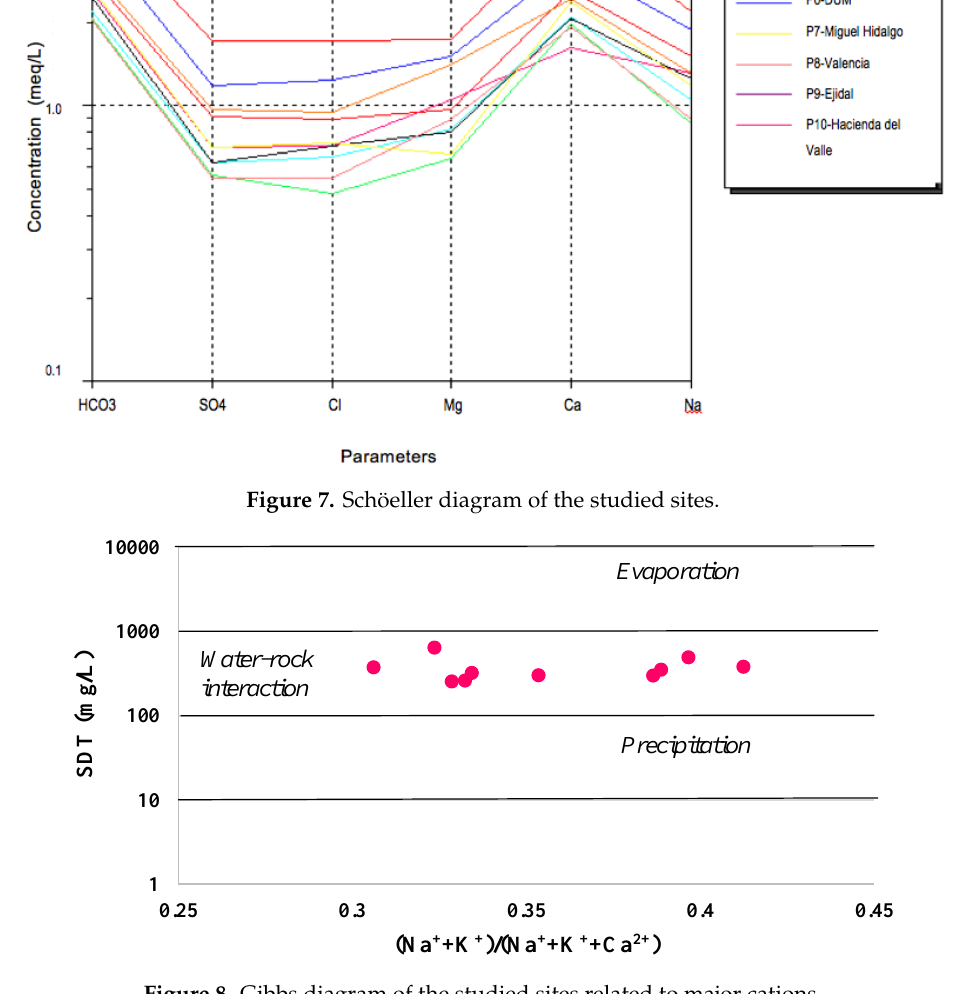
Figure 8. Gibbs diagram of the studied sites related to major cations.